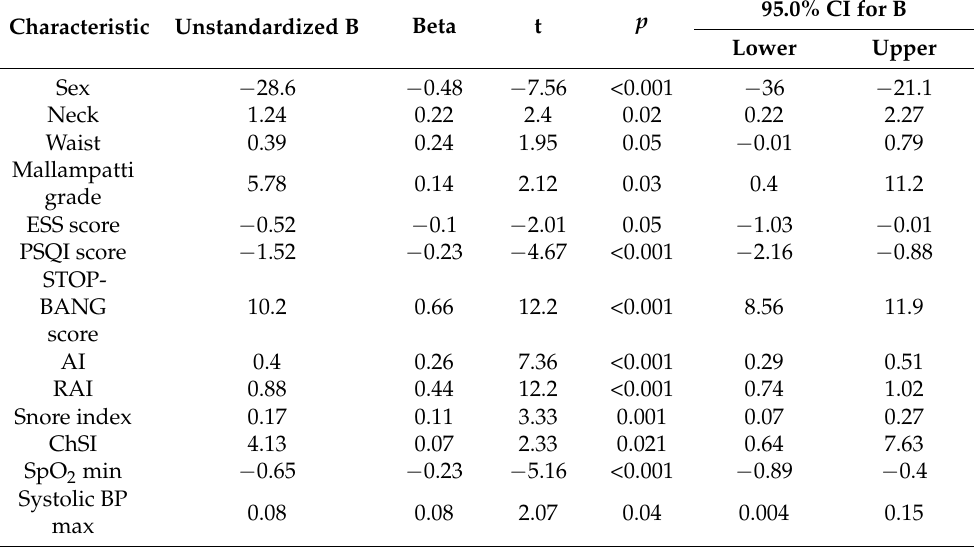
Table 5. Multiple regression analysis of factors related to AHI-defined OSA